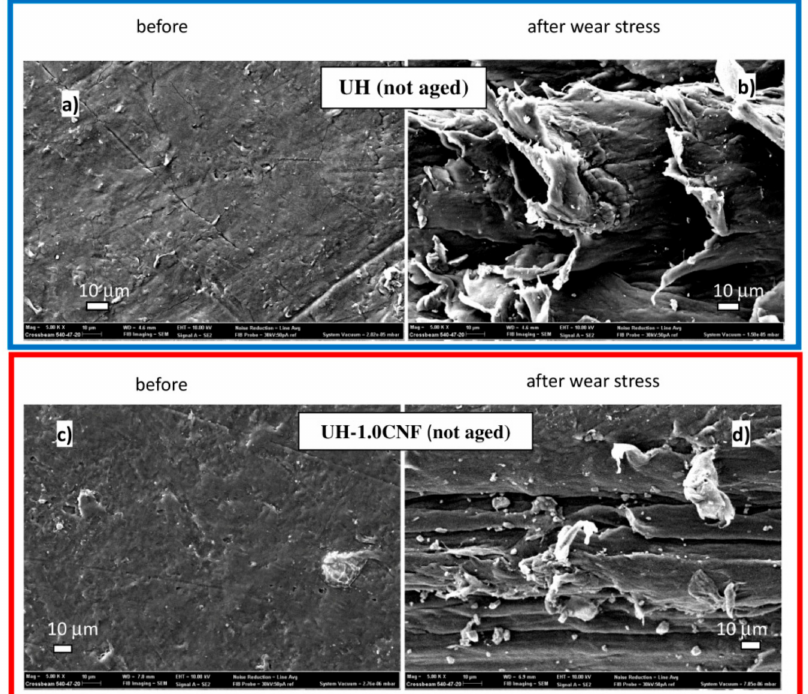
Figure 2. SEM micrographs at 5K × of the not aged external surfaces of: pristine UH before ( a ) and after the wear stress ( b ); pristine UH-1.0CNF before ( c ) and after the wear stress ( d